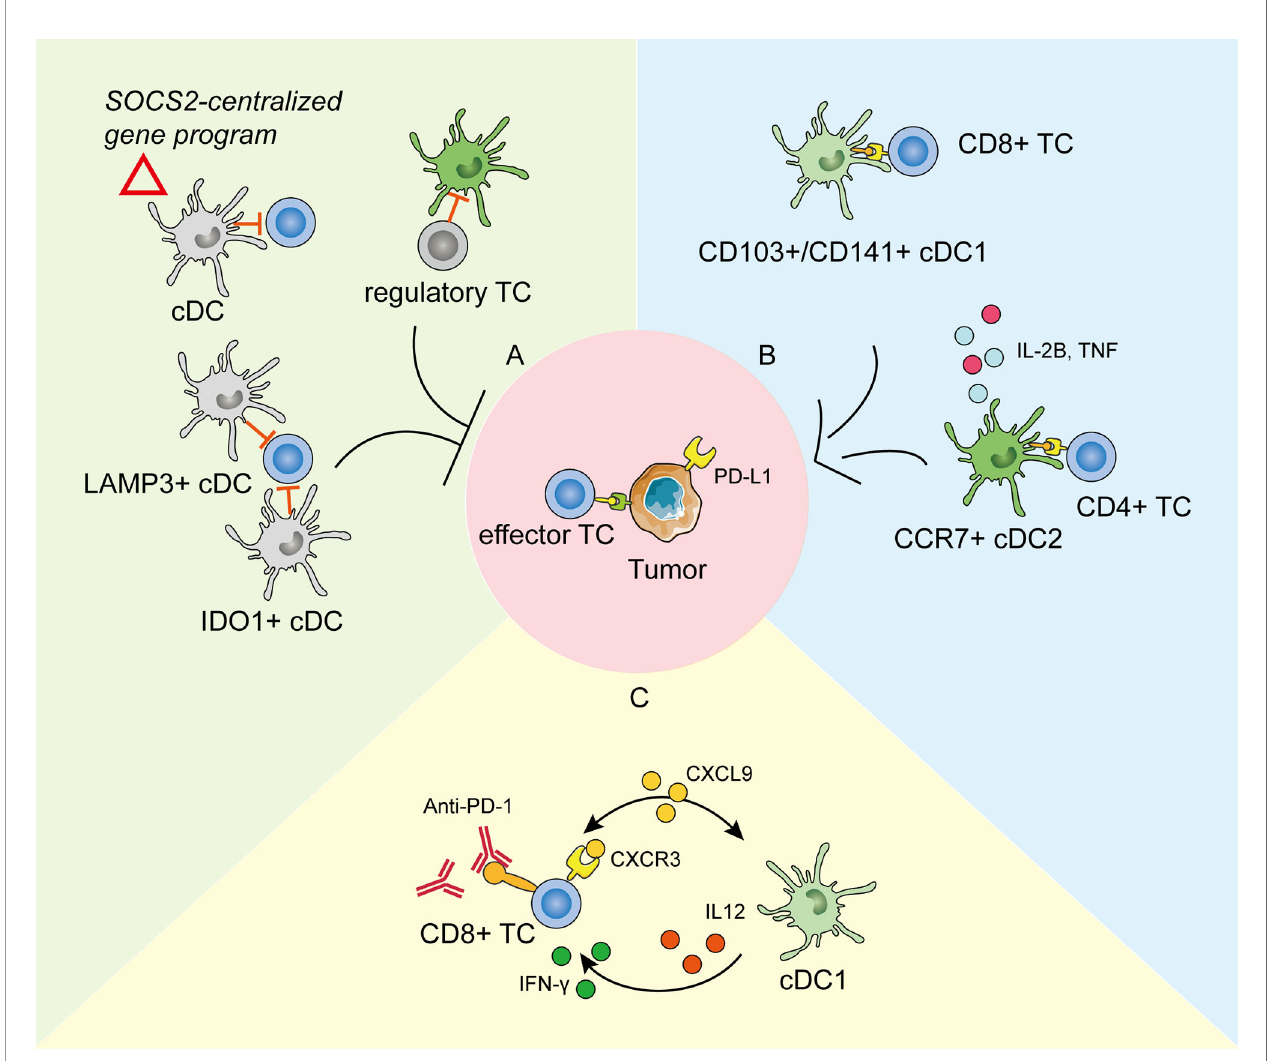
FIGURE 2 | The roles of tumor-in fi ltrating dendritic cells (DCs) in tumor development and anti-PD-1 immunotherapy as revealed by scRNA-seq. (A) DCs in the tumor environment could be modi fi ed to repress the anti-tumoral immunity and promote cancer development in different ways. cDCs expressing the SOCS2-centralized gene program could facilitate tumor immune surveillance (114). Clusters of IDO1 + cDCs and LAMP3 + cDCs are reported to repress the proliferation and function of effector T cells (115, 116). DCs could also be restrained by regulatory T cells (117). (B) cDC1s take in the tumor antigens and activate effector CD8 + T cells (TC). cDC2s activate the CD4 + TCs and secrete pro-in fl ammatory cytokines to promote anti-tumoral immunity. (C) The crosstalk between cDC1s and CD8 + TCs through chemokines and cytokines is pivotal in response to effective anti-PD-1